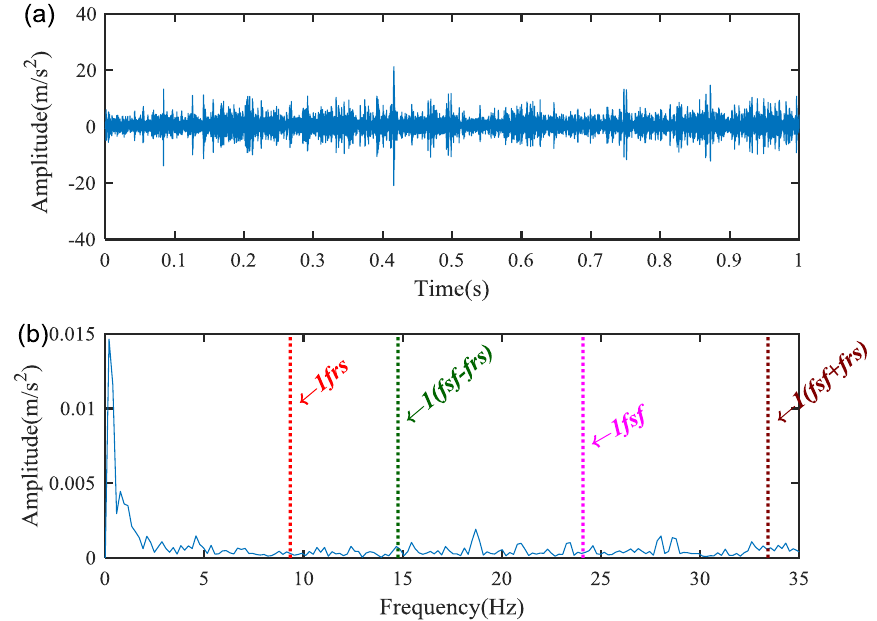
Figure 5. The raw vibration signal of the sun gear chipped: ( a ) the waveform, and ( b ) frequency spectrum.